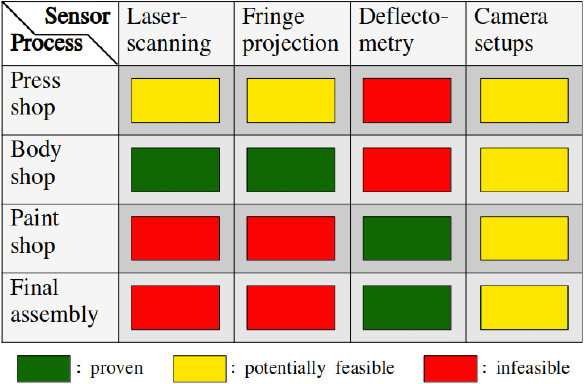
Figure 13. Available technologies: overview and